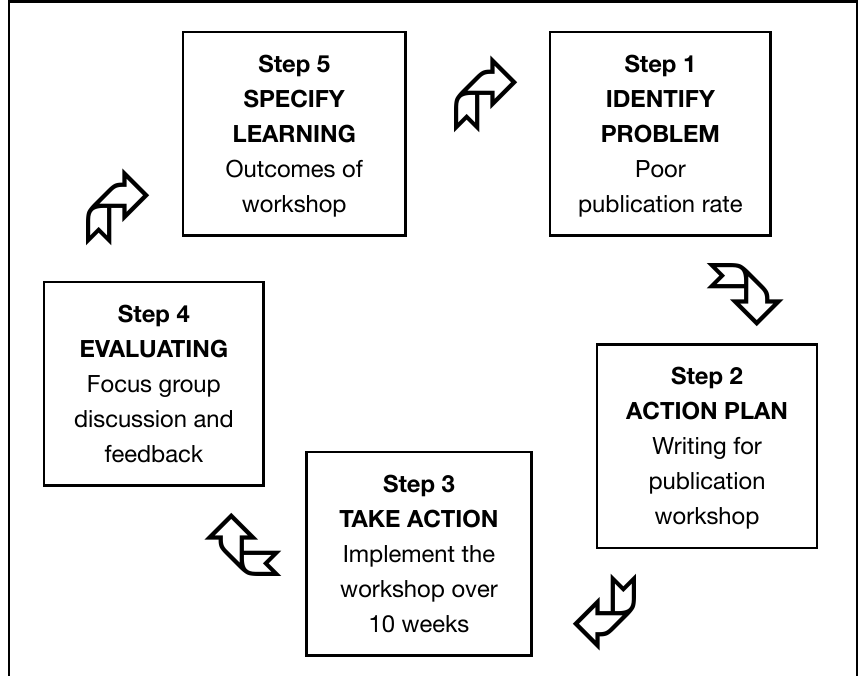
figure 1: Steps involved in Action Research